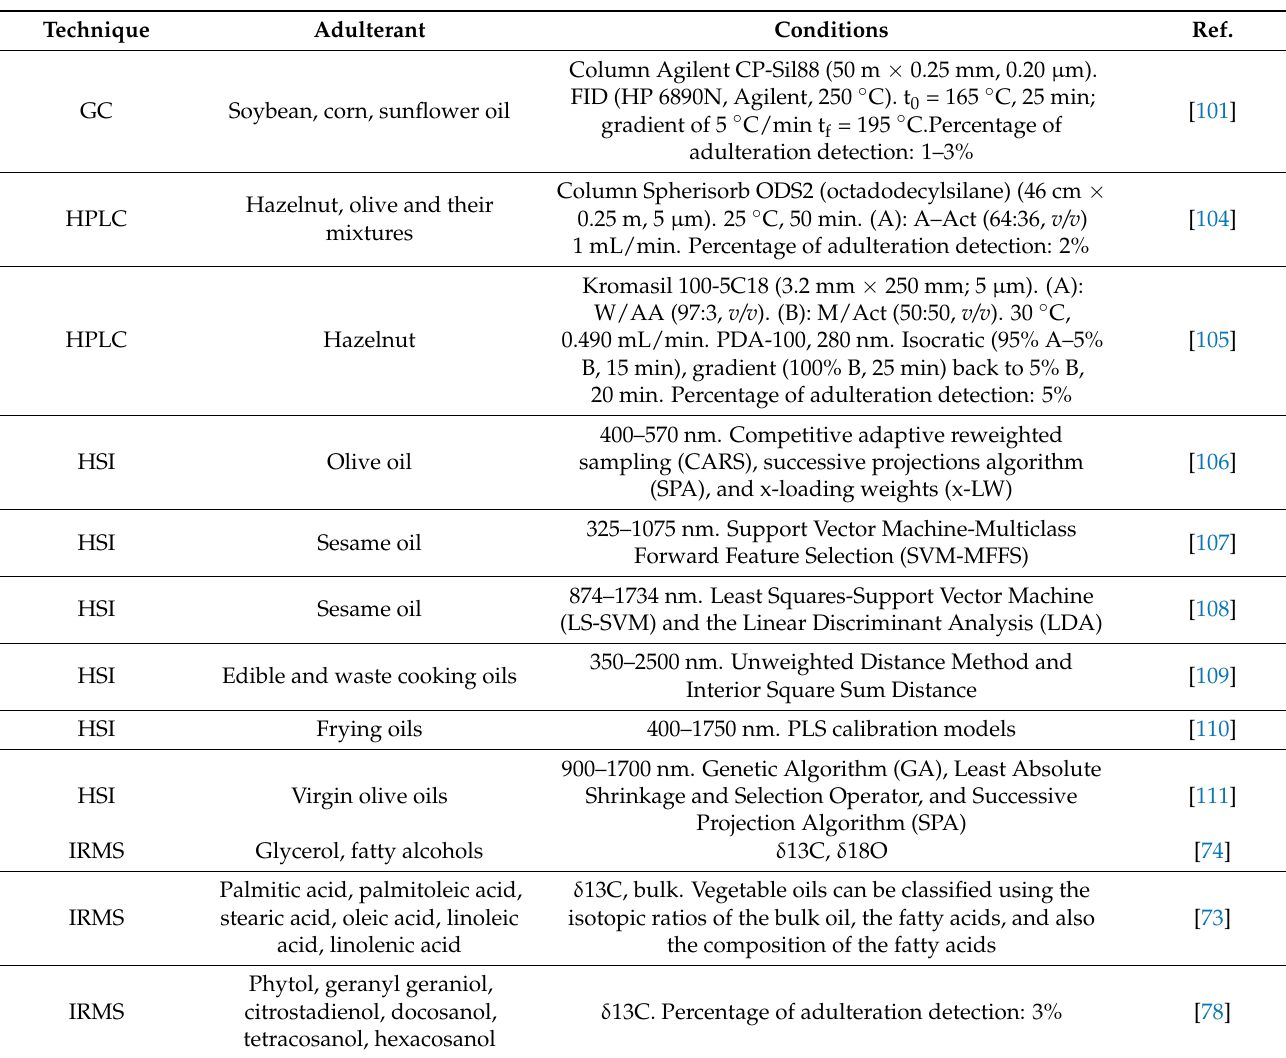
Table 2. Tests carried out with different identification and quantification techniques to determine and/or quantify adulter- ations in olive